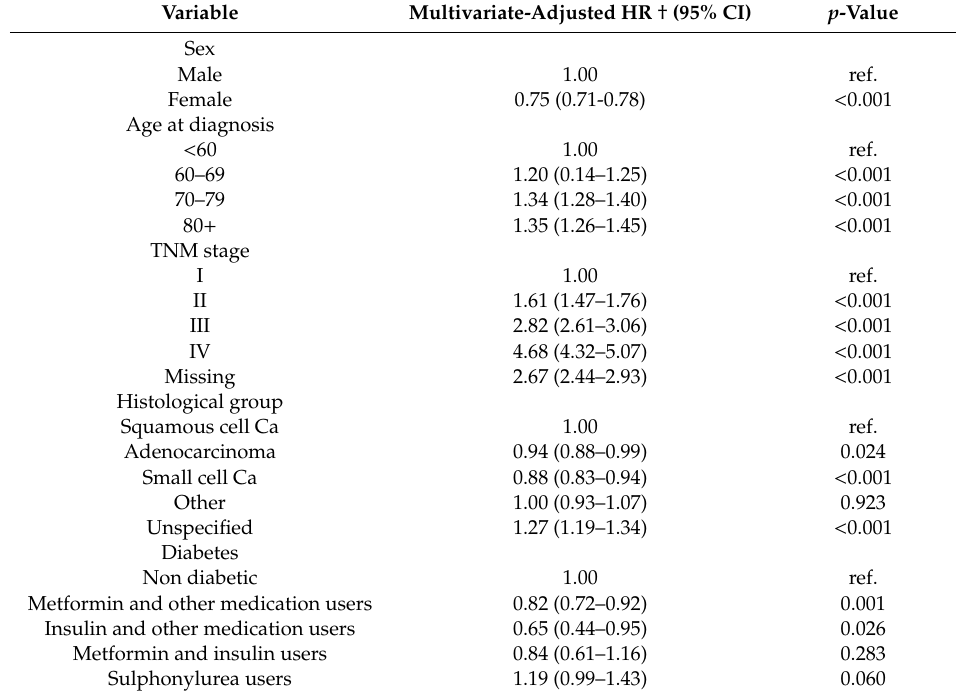
Table 2. HR and 95% CI of the association of diabetes, antidiabetic medications use and lung cancer-specific mortality.